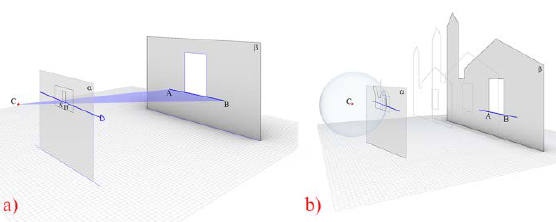
Figure 13. Geometric relationships to use spherical panoramas These geometrical/projective considerations were used to